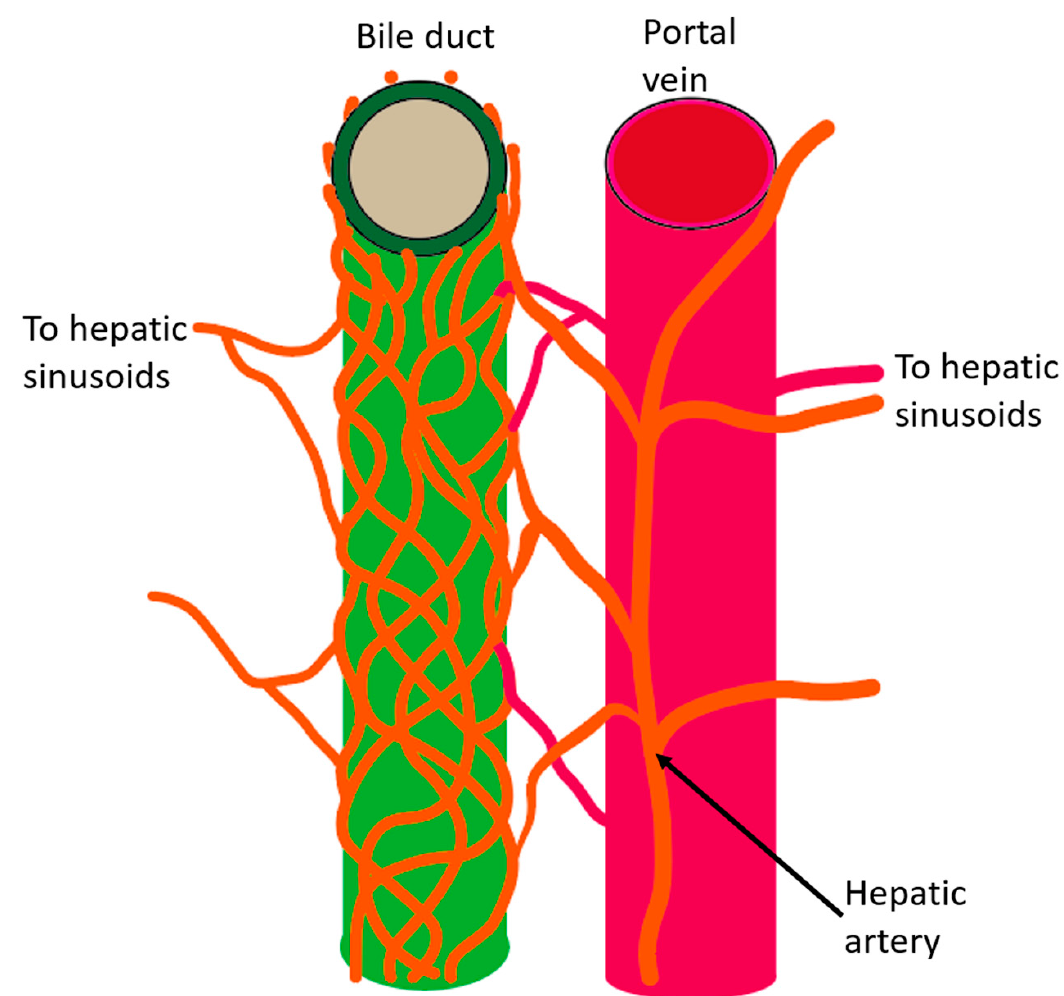
Figure 2. Schematic diagram of the intrahepatic bile duct and peribiliary vascular plexus (PBP). The larger intrahepatic biliary tract is supplied and nourished by a network of fine vessels called the PBP. Afferent vessels of this plexus derive from hepatic arterial branches, and this plexus drains into the portal venous system or directly into the hepatic sinusoids.